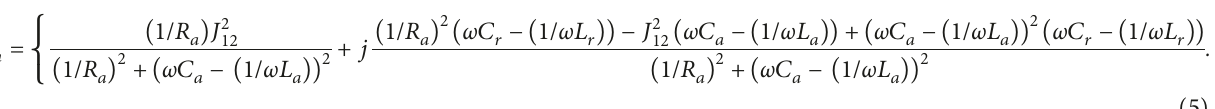
Table 1. Under simulation, the other dimension parameters are set as follows: W � 25.0 mm, L � 35.0 mm, W